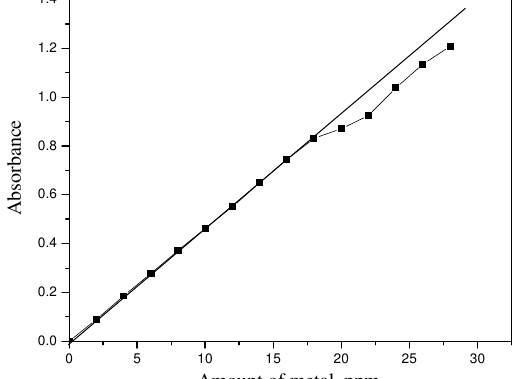
Figure 3. Applicability of Beer’s law to Pd(II)- 3,4-DHBINH complex; 3,4 -DHBINH: 1.0 mL : 380 of 1.0×10 −3 M; pH: 3.0; λ max